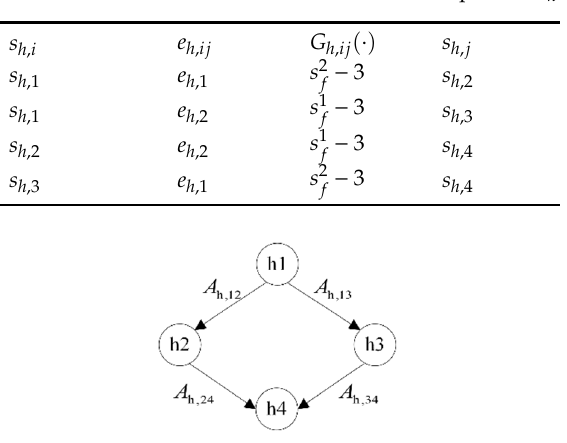
Table 3. List of the status transfer for hot backup SHA A h .